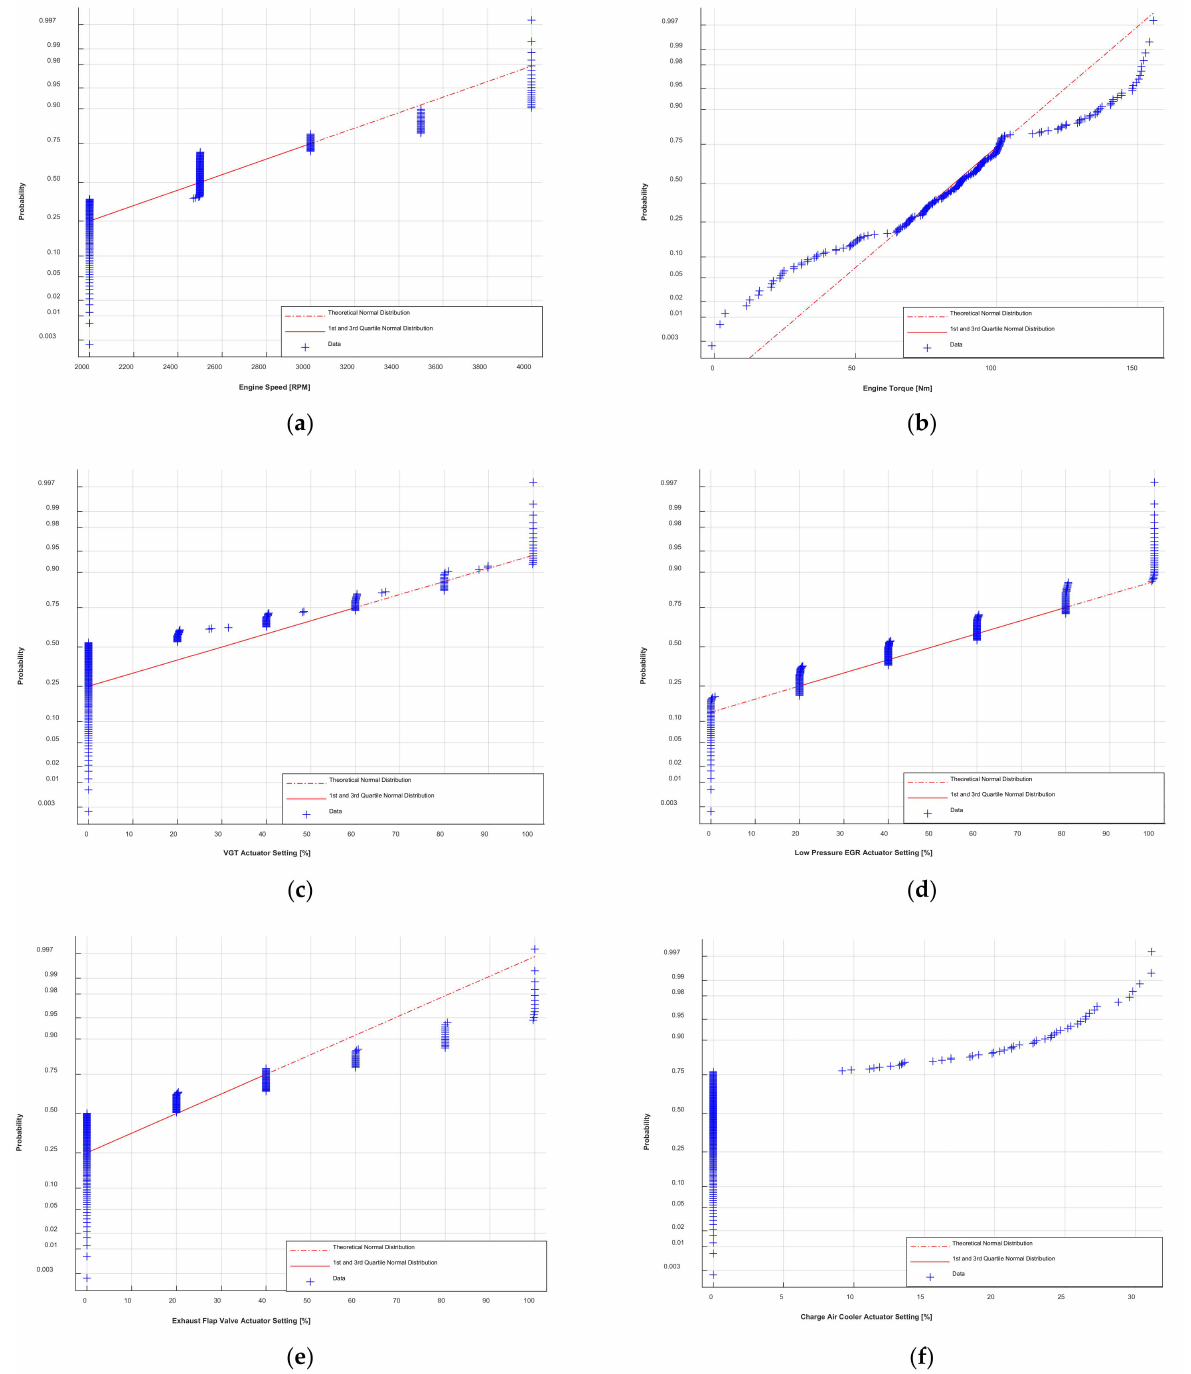
Figure 3. This figure shows the normal probability distribution plots of six (6) engine parameters across the 212 experimental data collected for this study: ( a ) engine speed normal probability distribution; ( b ) torque normal probability distribution; ( c ) VGT actuator settings normal probability distribution; ( d ) low-pressure EGR actuator settings normal probability distribution; ( e ) exhaust flap valve position normal probability distribution; ( f ) CAC settings normal probability